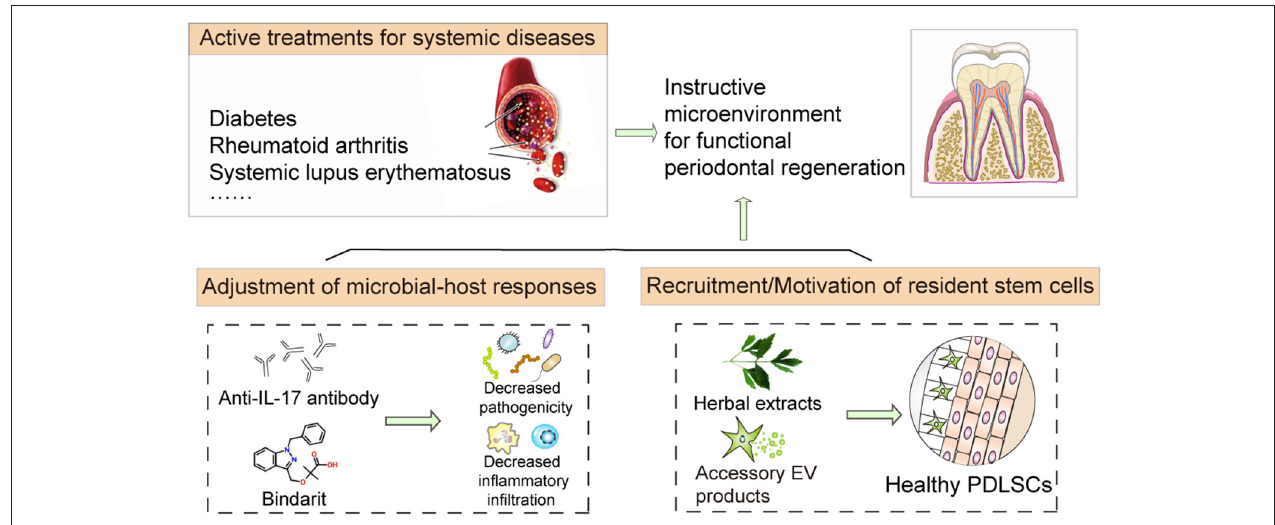
FIGURE 4 | Coping strategies mitigating host factors for improving stem cell therapy. The application of biological products, including small molecular drugs, herbal extracts, and accessory extracellular vesicle products, can effectively improve the extracellular environment and promote stem cell function, thus alleviating periodontal defects in periodontitis. Significantly, active treatments for systemic diseases would also assist stem cell-mediated regeneration based on the amelioration of the inflammatory niche and maintenance of the instructive